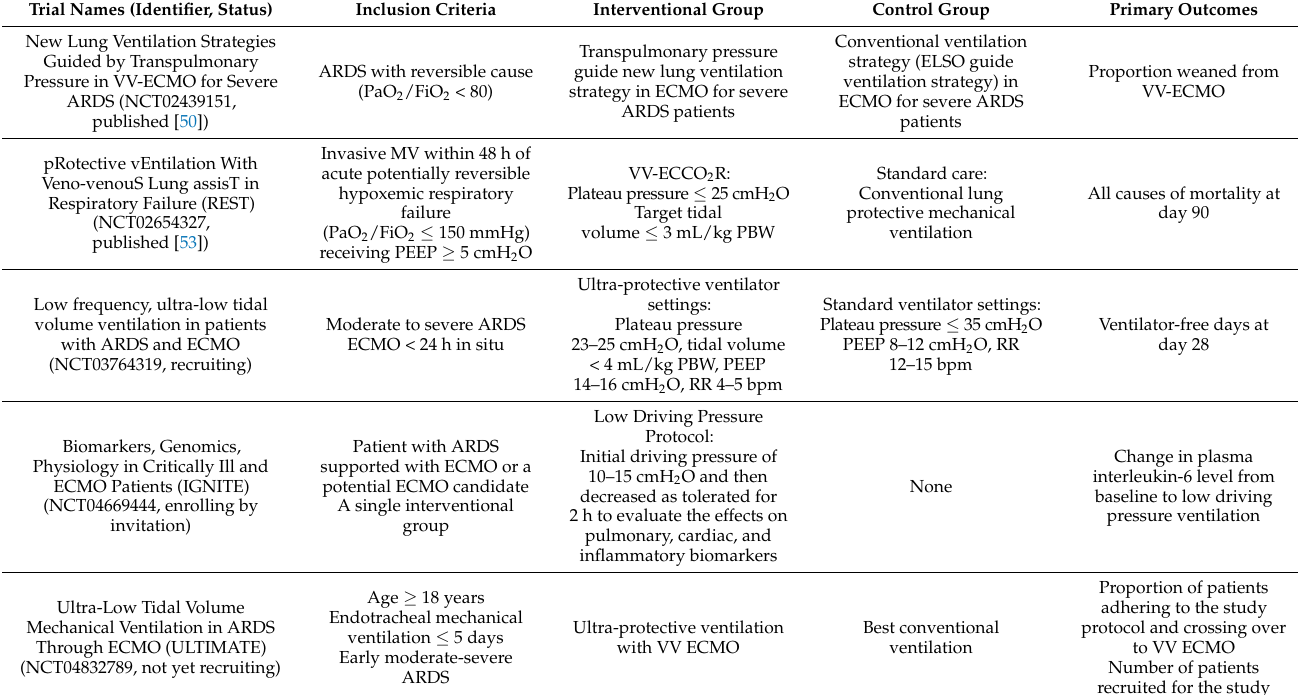
Table 4. Overview of ongoing clinical trials pertaining to mechanical ventilation during ECMO for patients with